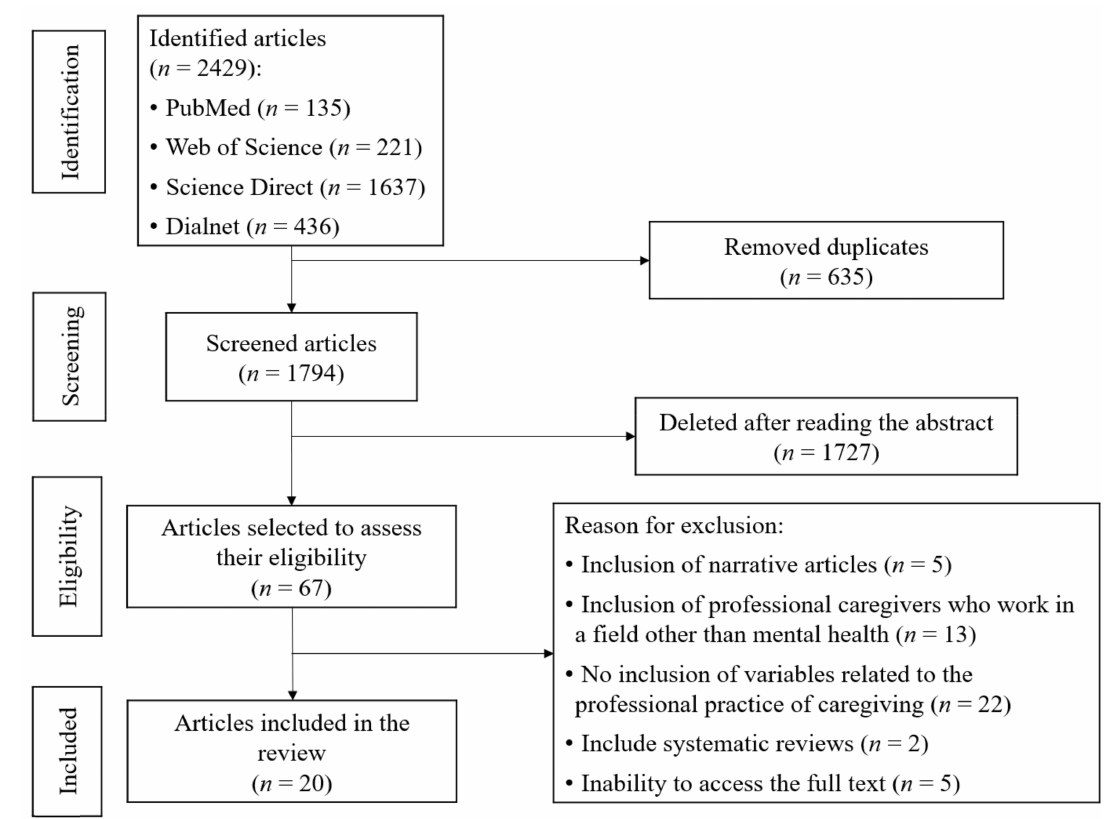
Figure 1. PRISMA